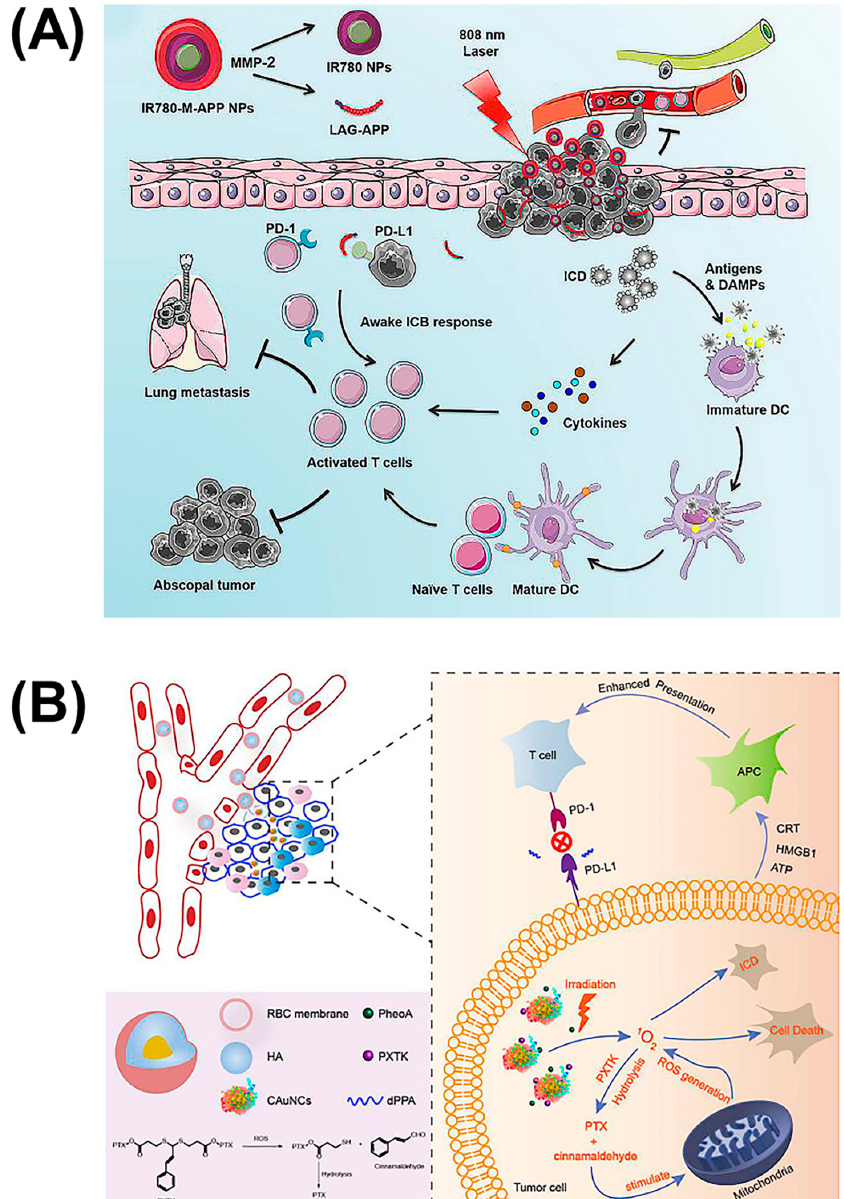
Figure 6. Self-assembled nanoparticles of reduced size combined with PDT to inhibit tumor metastasis. ( A ) Nanoparticles composed of photosensitizer IR780 and anti-PD-L1 peptide D PPA-1, which can be triggered to transition to a smaller size by MMP-2 for advanced cancers. Reproduced from Reference [42] with permission. Copyright: 2020 Elsevier. ( B ) Hyaluronidase-responsive